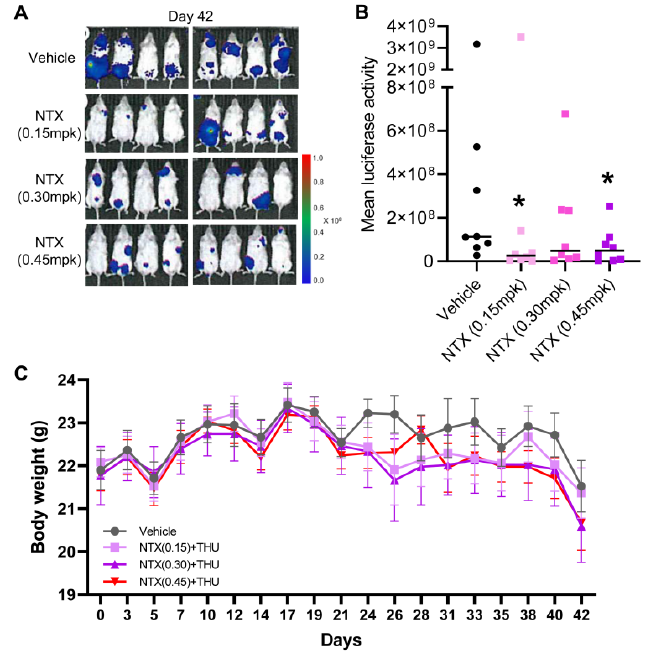
Figure 3. The antitumor efficacy of low doses of NTX-301 in a preclinical model of AML. ( A – C ), Bioluminescence images of tumor growth ( A ), quantitative measurements of the bioluminescence emission (photons/sec) ( B ), and body weight ( C ) of NOD/SCID mice (n = 8 per group) that were transplanted with luciferase-labeled MV4-11 cells and treated with NTX-301 (p.o., daily at 0.15, 0.30, or 0.45 mg/kg (mpk) in combination with tetrahydrouridine (THU, 42.0 mg/kg)) on day 42. *, p < 0.05.